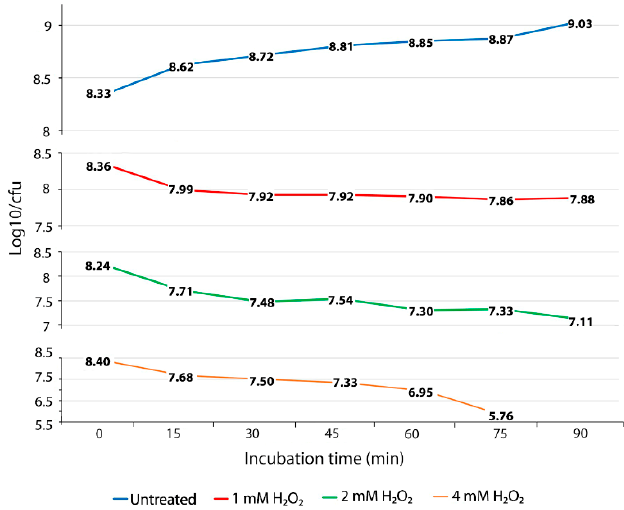
Figure 1 . Oxidative stress killing assay. Mortality of S. Enteritidis, expressed by reduced log 10 /CFU for every 15 min of the H 2 O 2 treatment. The data correspond to the mean value of three biological replications. Each measurement value was composed of nine replications (each biological replication was made up of three technical replications).